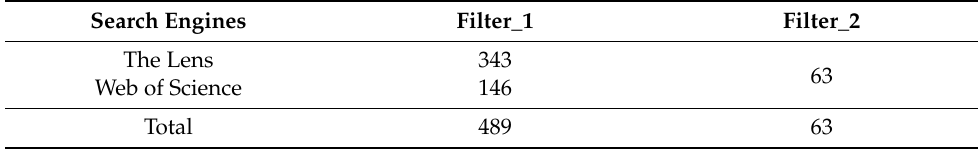
Table 2. Number of documents obtained from search engines.